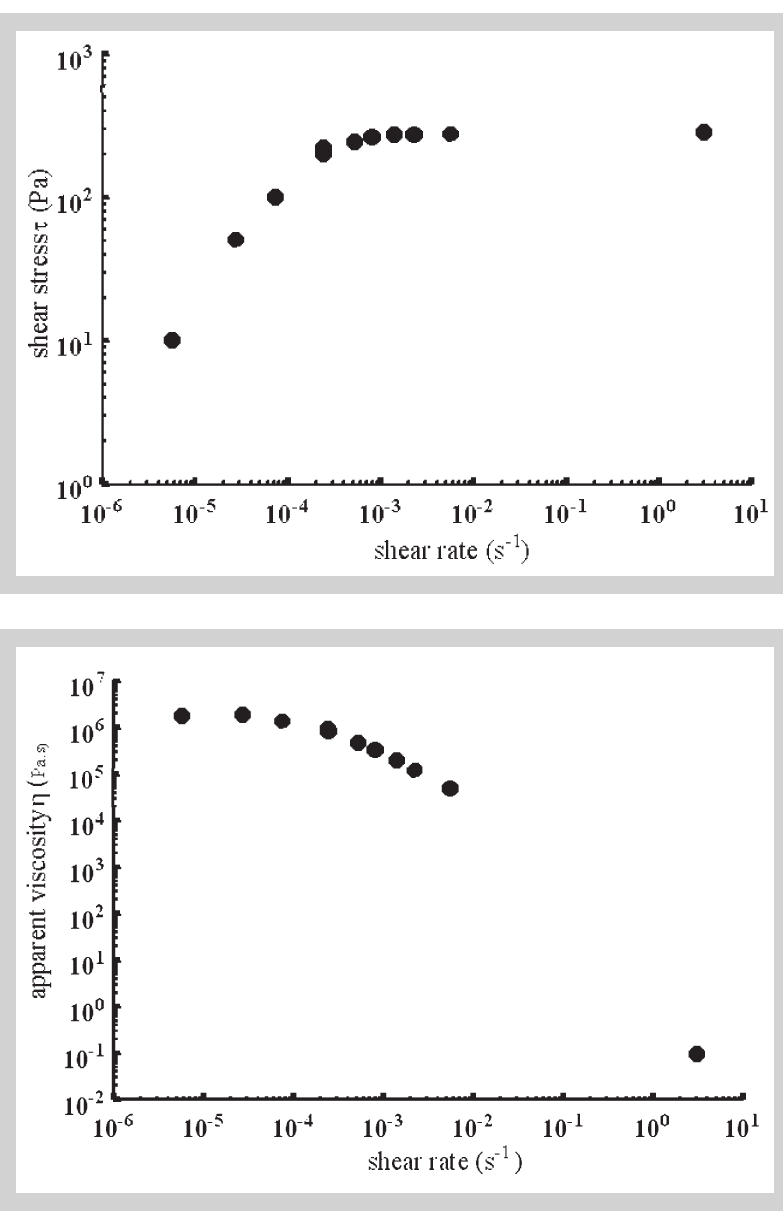
Figure 3: The flow curve of a 1380 kg/m3 mud sample, as obtained from creep tests: